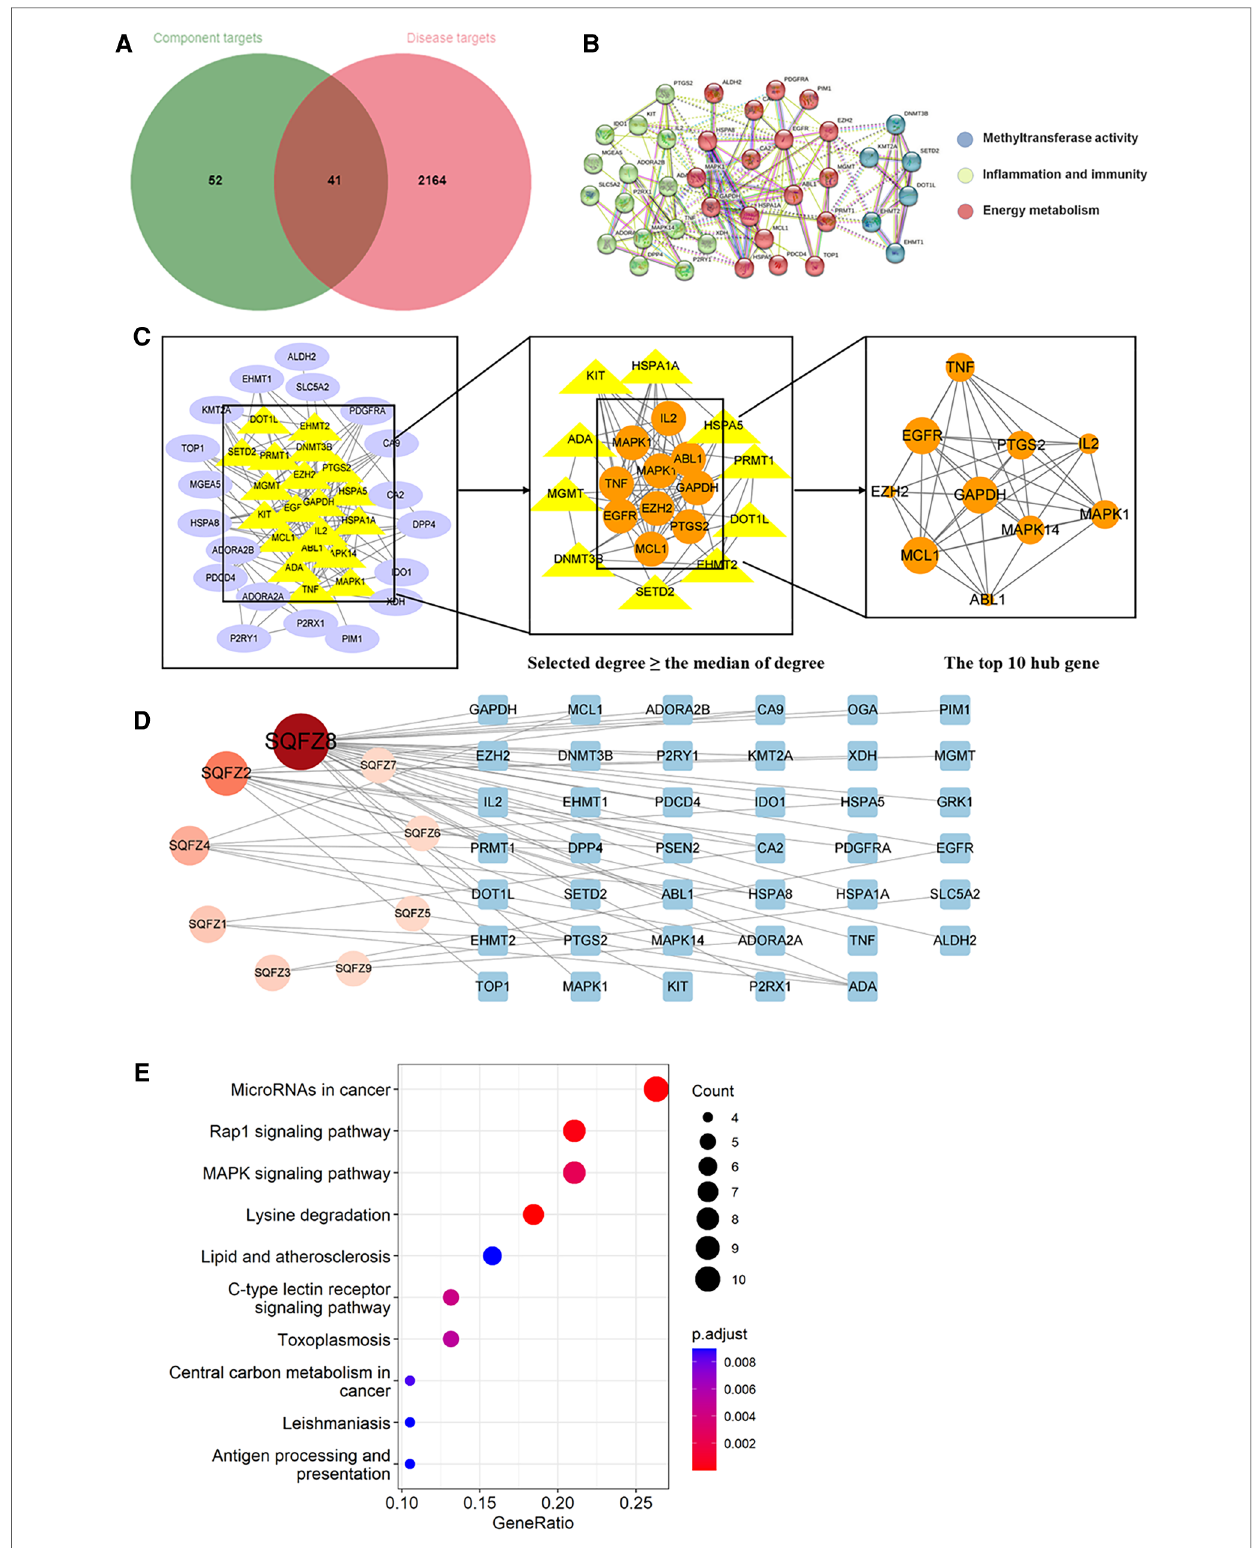
FIGURE 9 Analysis of target genes about shenqifuzheng injection. ( A ) Venn diagram of component target genes and disease target genes. The green circle stands for effective component target genes. The red circle stands for AIC target genes, and the intersection genes are shown in the middle. ( B ) The PPI network of the intersection genes. ( C ) Network topology analysis to screen the hub targets. ( D ) Component-Target Network of the active components and the target genes. ( E ) KEGG enrichment analysis of hub